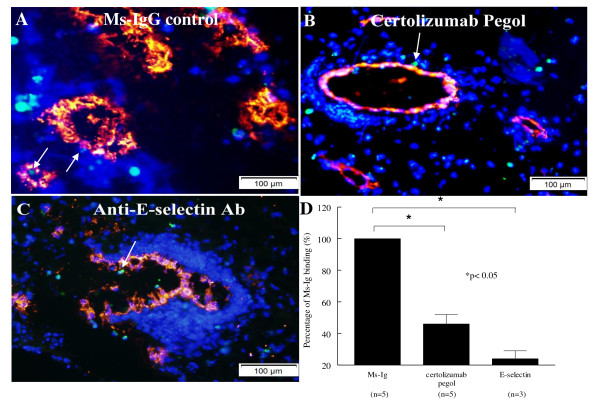
Certolizumab pegol inhibits HL-60 adhesion to rheumatoid arthritis synovial tissue vessels. Stamper-Woodruff assay and immunofluorescence were performed using frozen rheumatoid arthritis (RA) synovial tissue (ST) sections and fluorescence-labeled human promyelocytic leukemia (HL-60) cells. Synovial vessels are marked by von Willebrand factor antibody in red; calcein AM-labeled HL-60 cells appear as green dots; and cell nuclei are stained blue with 4',6-diamidino-2-phenylindole. HL-60 cells adhere to the synovial vessels (×200) when treated with: (A) mouse-IgG (Ms-Ig; negative control); (B) certolizumab pegol (10 μg/ml); or (C) anti-E-selectin antibody (Ab; positive control). The arrows in (A) to (C) point to HL-60 cells bound to vasculature. The adhesion ratio of each section was determined as the sum of adherent HL-60 cells divided by the sum of blood vessels in up to 10 fields of each section. (D) Adhesion results of the different treatments given as the percentage of Ms-Ig binding, defined as the adhesion ratio of the test group divided by the adhesion ratio of Ms-Ig-treated sections. Results represent the percentage of Ms-Ig binding ± standard error of the mean. n, number of RA patients. *P < 0.05.